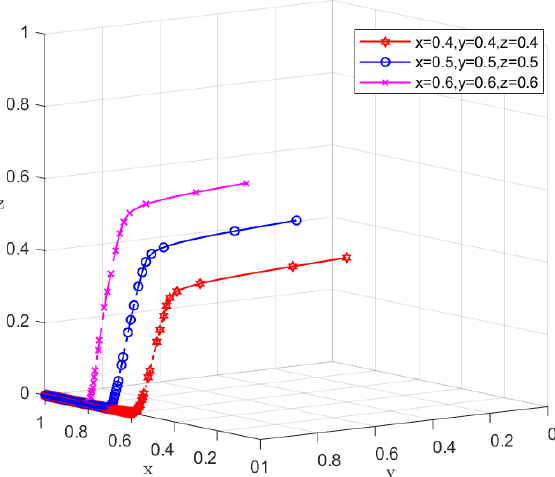
Figure 4. Evolutionary game diagram of three parties under different initial wills.